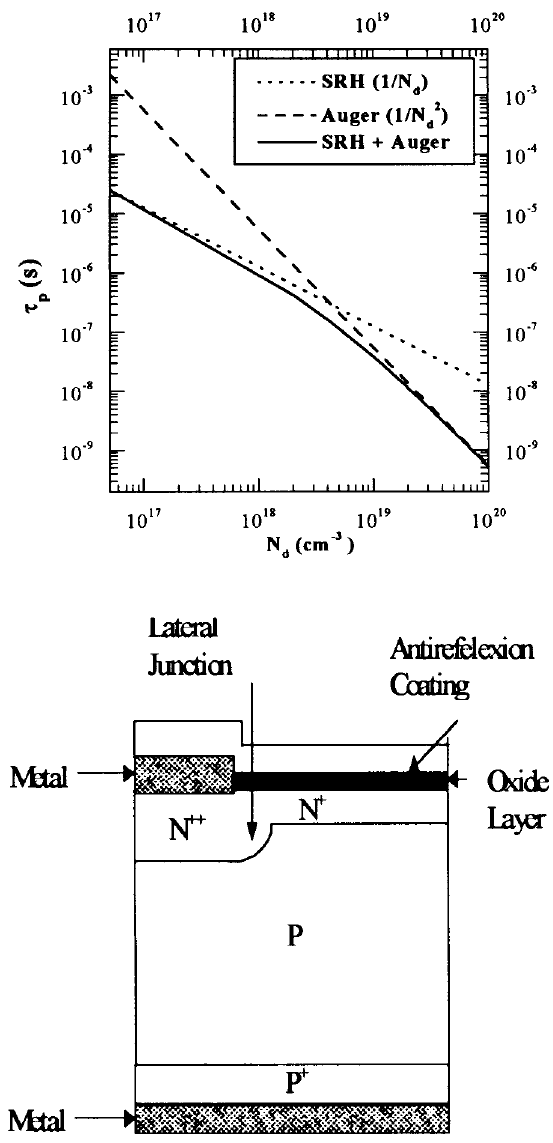
FIGURE 4 a: Representation of the minority carrier lifetime with respect to N D for the two mechanisms of recombination; b: Shames of the n þ p considered solar